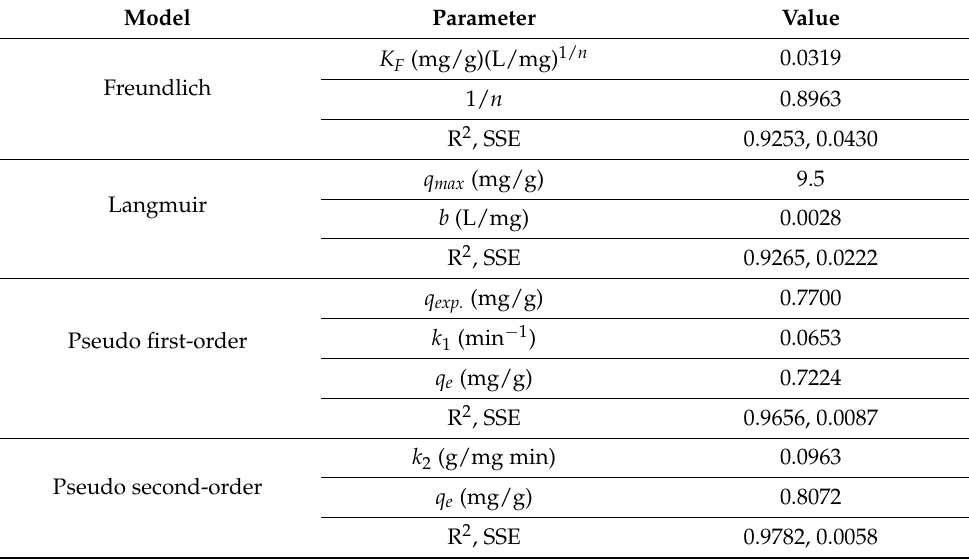
Table 1. Constants of equilibrium and kinetic models for removal of SO 42 − ions from contaminated water onto the prepared